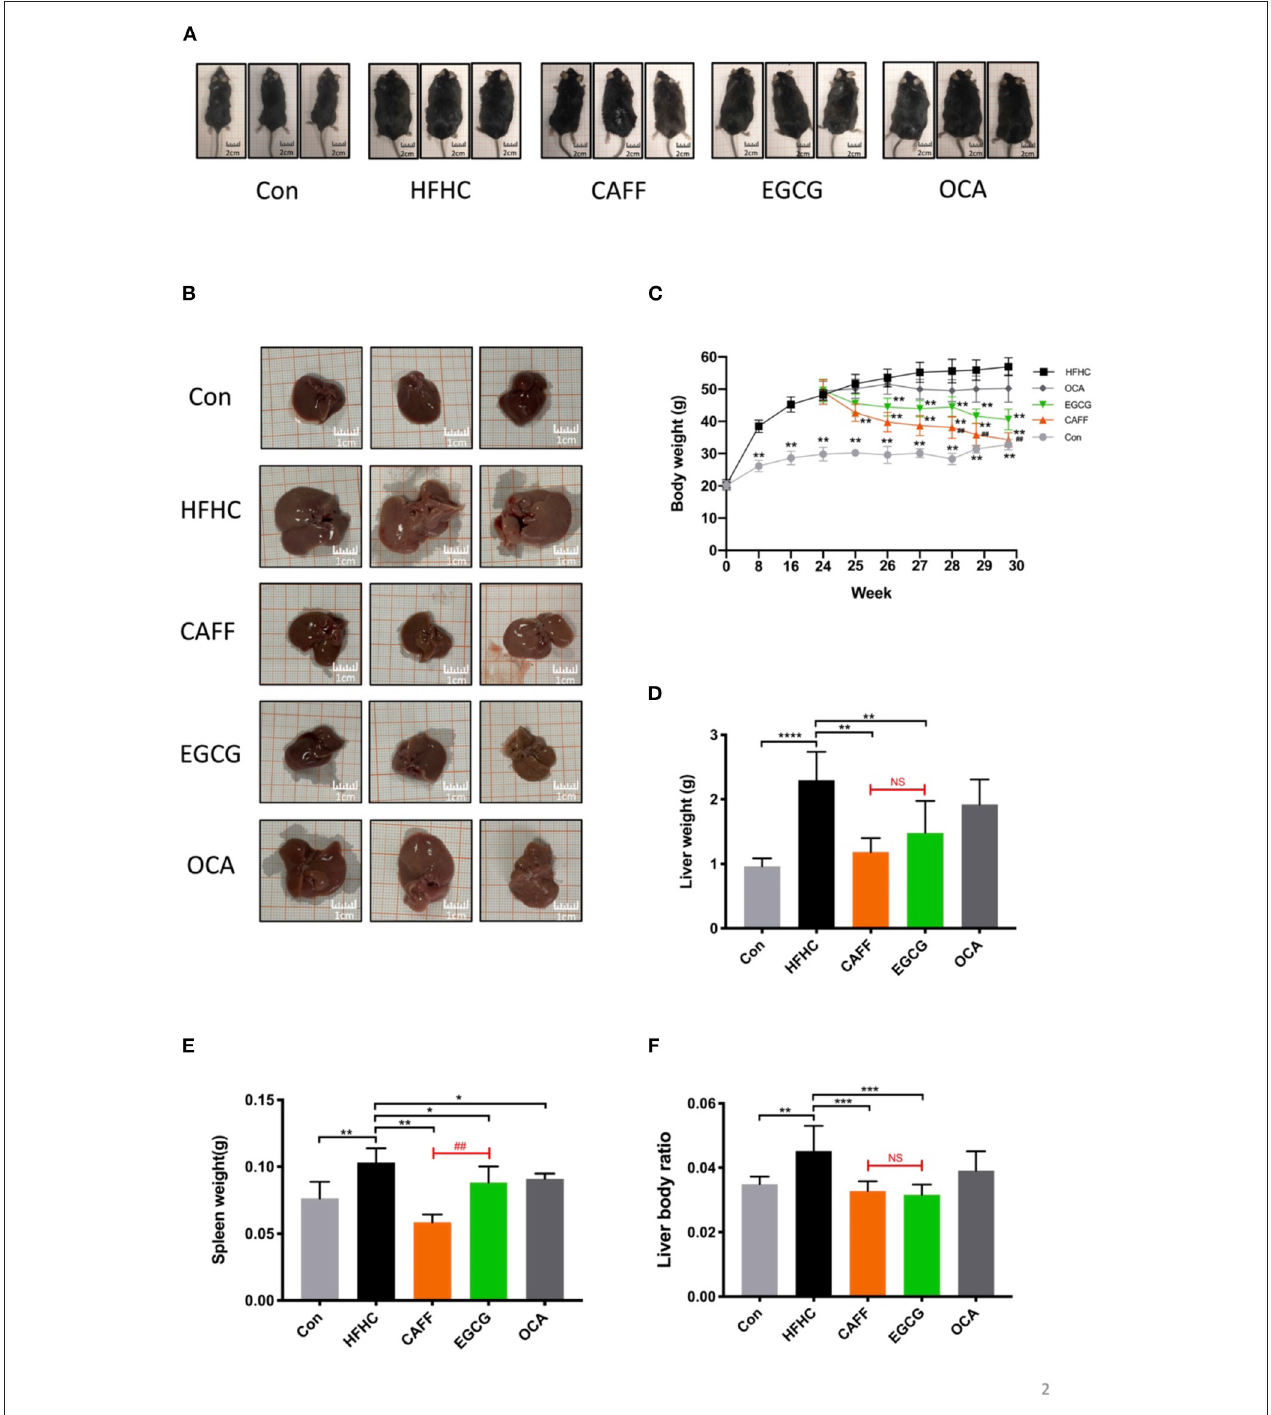
FIGURE 2 | The general condition of mice in each group. (A) Representative pictures of mice morphology in each group at sacrifice. (B) Representative pictures of liver morphology in each group at sacrifice. Changes in body weight (C) , liver weight (D) , spleen weight (E) and liver body ratio (F) of the mice in each group ( n = 8) vs. HFHC, * P < 0.05, ** P < 0.01, *** P < 0.001, **** P < 0.0001; vs. EGCG, ## P < 0.01, NS, not significant. the extent of liver fibrosis in mice of each group was